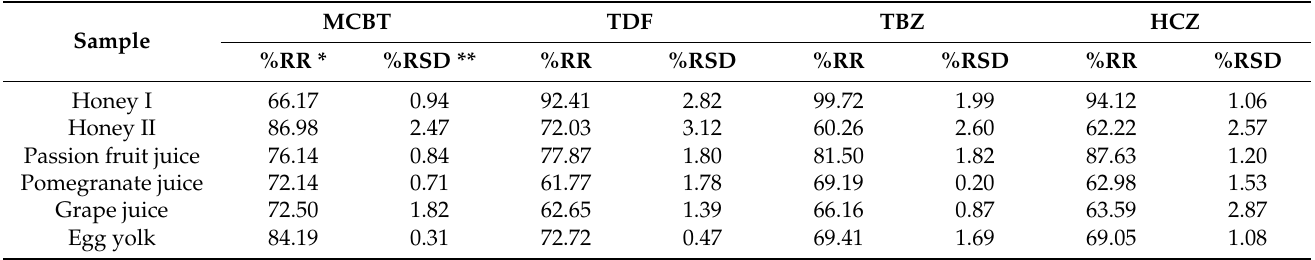
Figure 7. Chromatograms of sample and spiked sample (150 µ g L − 1 for fruit juice sample and 150 µ g kg − 1 for honey and egg samples); ( a ) honey sample, ( b ) passion fruit juice sample, ( c ) pomegranate juice sample and ( d ) egg yolk sample. Table 2. Recoveries obtained from the analysis of triazole fungicides in real samples (n =